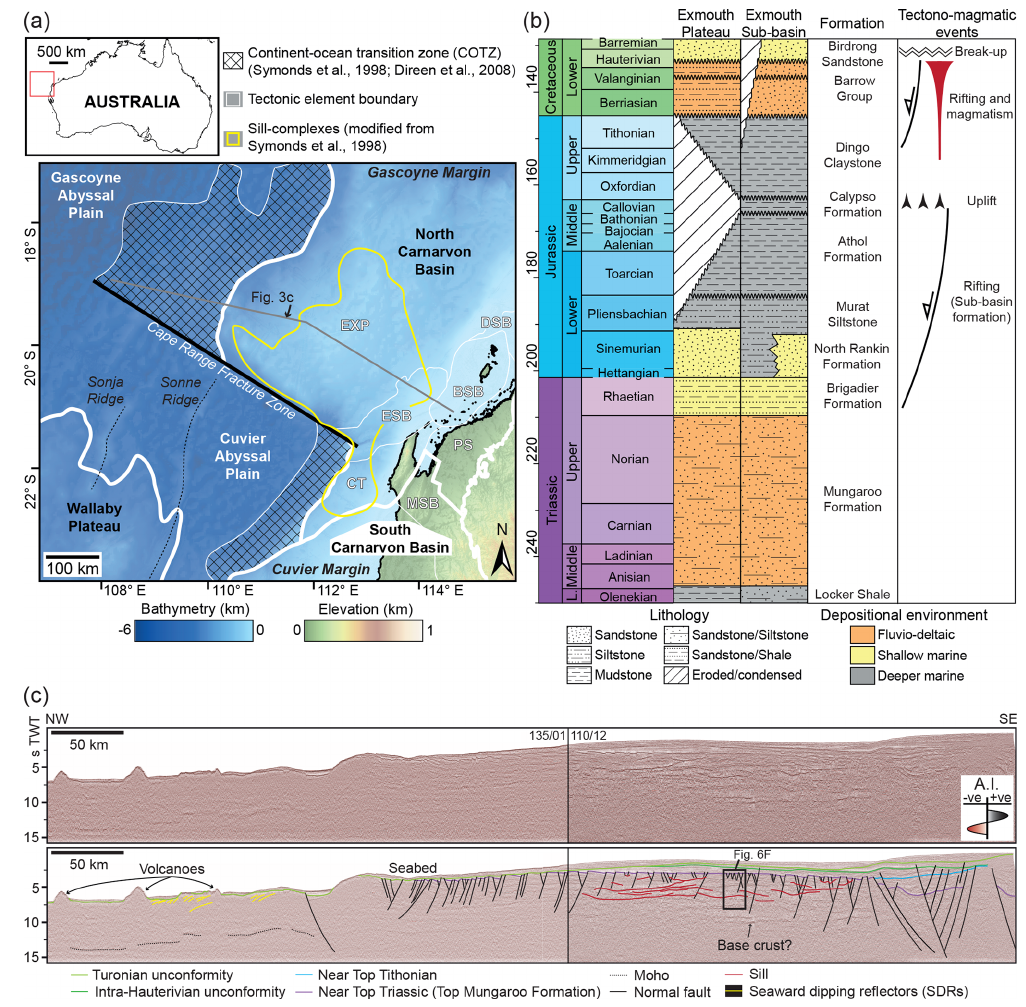
Figure 3. (a) Location map of the southern portion of the North Carnarvon Basin, which spans the Gascoyne Margin and extends onto the Cu- vier Margin. Key tectonic elements include EXP = Exmouth Plateau; DSB = Dampier Sub-basin; BSB = Barrow Sub-basin; ESB = Exmouth Sub-basin; CT = Carnarvon Terrace; MSB = Merlinleigh Sub-basin; and the PS = Peedamullah Shelf. The map also shows the approximate boundary of sill complexes in the North Carnarvon Basin (modified from Symonds et al., 1998; Holford et al., 2013). (b) Tectono-stratigraphic column for the Exmouth Plateau and Exmouth Sub-basin, which also highlights the relative duration and abundance of Late Jurassic-to-Early Cretaceous magmatism (based on Symonds et al., 1998; Tindale et al., 1998; Longley et al., 2002; Reeve et al., 2016). Undulating lines mark unconformities. (c) Uninterpreted and interpreted seismic section, combining lines AGSO 135/01 and AGSO 110/12, showing the crustal structure of the study area (see Fig. 3a for location). Reflection polarity here, and elsewhere, is defined by a schematic seismic wavelet showing acoustic impedance (A.I.). See Supplement Fig. S1 for an enlarged